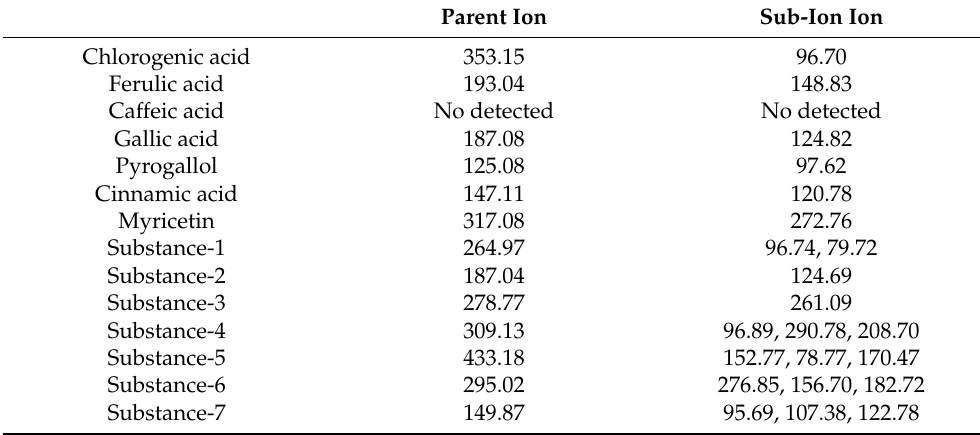
Figure 2. The chromatogram of L. hatsudake extracts analyzed by HPLC. ( A ) Standard mixture of phenolic; ( B ) phenolic profiles extracted from L. hatsudake . 1 gallic acid; 2 pyrogallol; 3 chlorogenic acid; 4 caffeic acid; 5 ferulic acid; 6 myricetin; and 7 cinnamic acid. Table 2. Mass spectrometric results of substances in purified products.